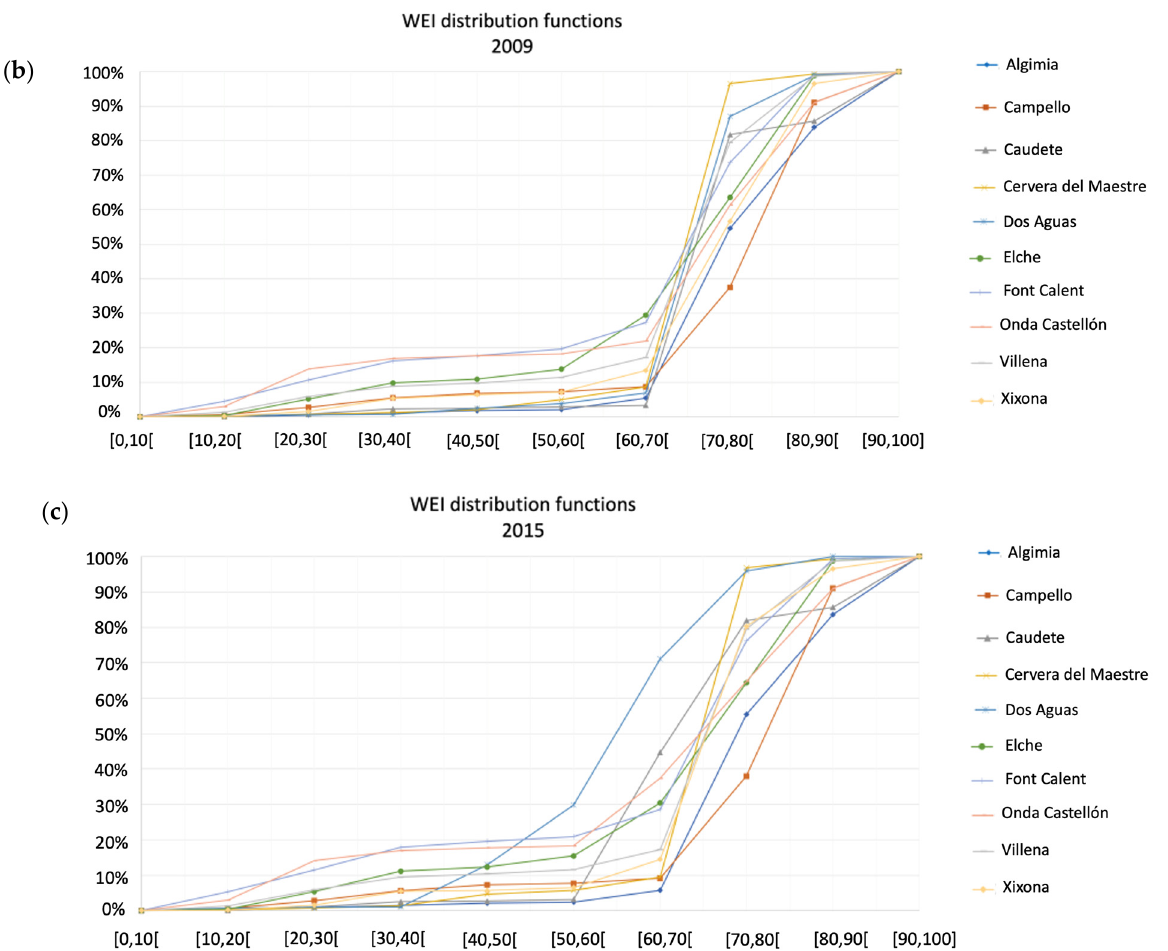
Figure 6. Evolution of the WEI distribution functions inside the landfill influence area for ( a ) 2005, ( b ) 2009, and ( c ) 2015